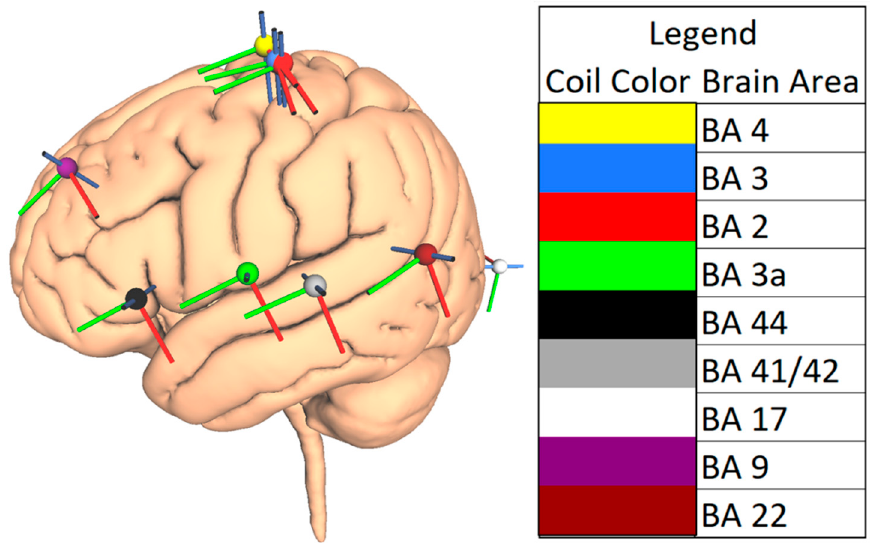
Figure 2. Cortical brain areas studied. The positions of the nine clinically important coil locations (projected on the cortical surface) selected for this study are shown. For example, BA4 represents Brodmann area 4, which is representative of the primary motor cortex. The legend lists the color codes and names of coil locations.